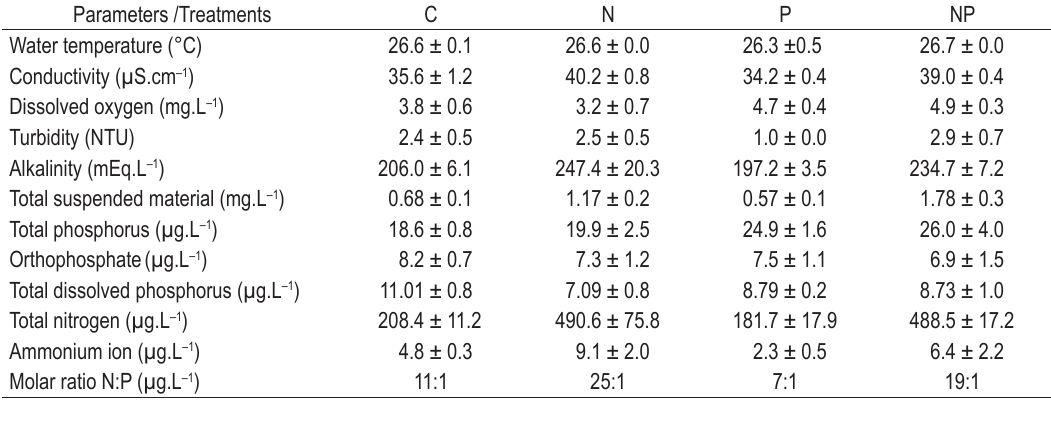
Table 1. Values (average) and standard deviation obtained for physical and chemical parameters in each treatment. Control treatment (C); nitrogen treatment (N); phosphorus treatment (P) and nitrogen plus phosphorus treatments (NP).